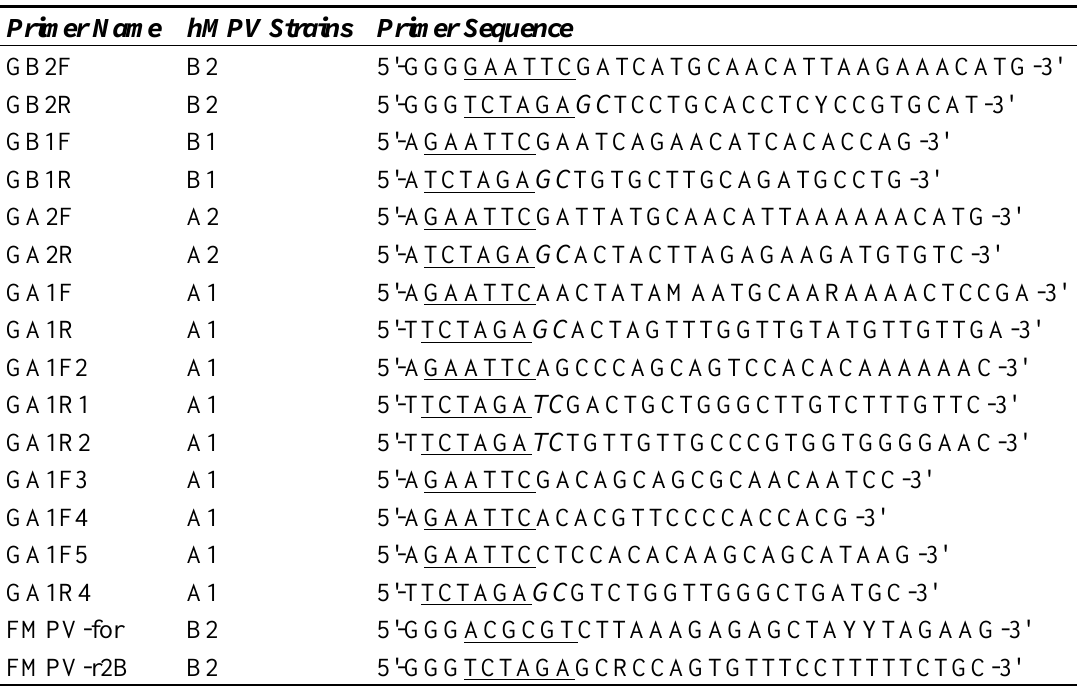
Table 2. Primers used to amplify the extracellular region of the hMPV strains A1, A2, B1 and B2, hMPV-G A1 strain fragments and the hMPV F extracellular region. Restriction sites incorporated for ease of cloning are underlined; EcoRI (GAATTC), MluI (ACGCGT) and XbaI (TCTAGA). Bases incorporated to remain in frame with the C-terminal tags are shown in